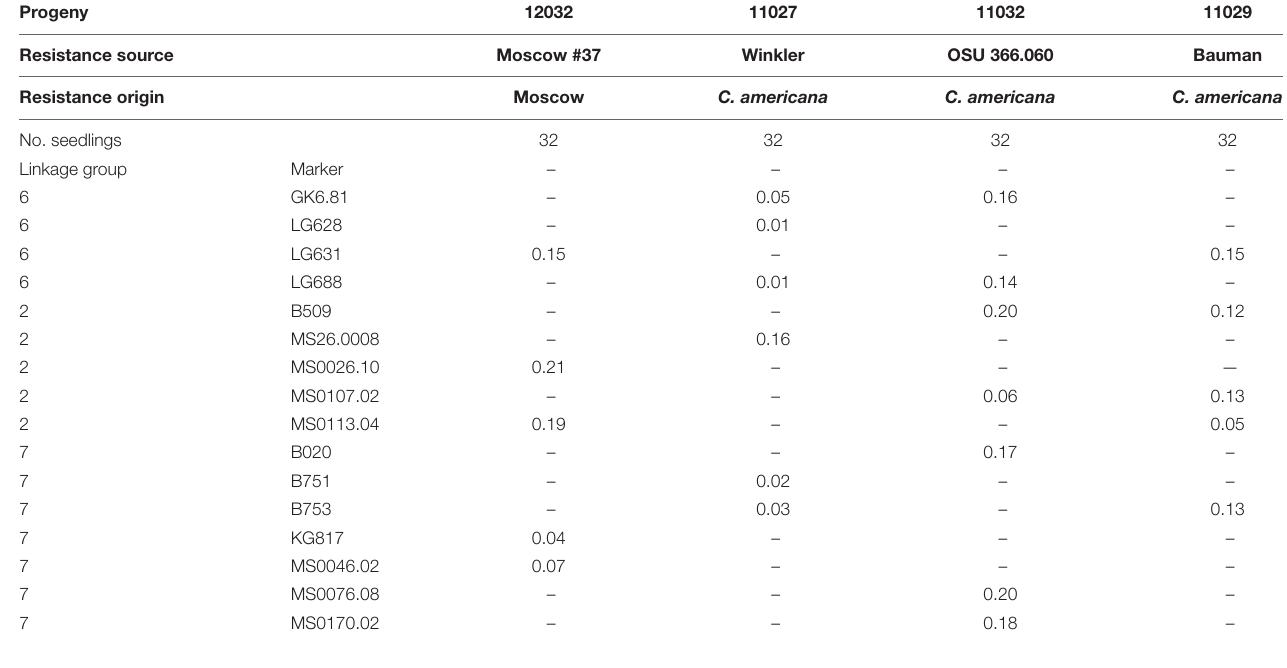
The markers are on three linkage groups. Low values indicate independence of disease and marker scores.